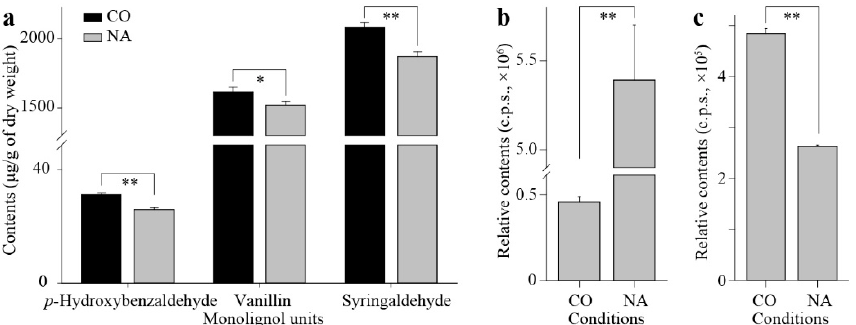
Figure 6. The kenaf stem growth was significantly retarded by the salt stress. Relative contents of three monolignol units ( a ), the stress hormone ABA ( b ) and the growth hormone IAA ( c ) in the whole stem at normal (CO) or adverse (NA) conditions were presented, respectively. The * or ** indicate the significant difference at threshold of 0.05 or 0.01 under Student’s t-test, respectively.